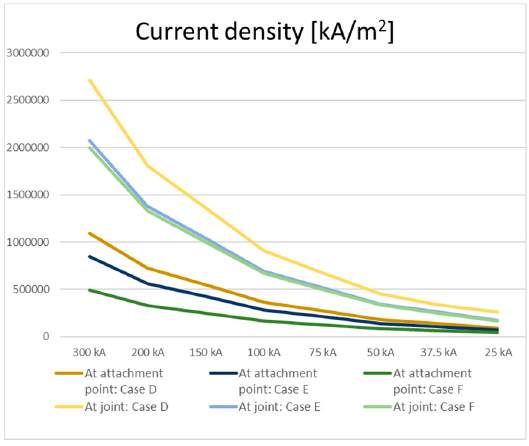
Figure 7. Current density of hybrid case studies.